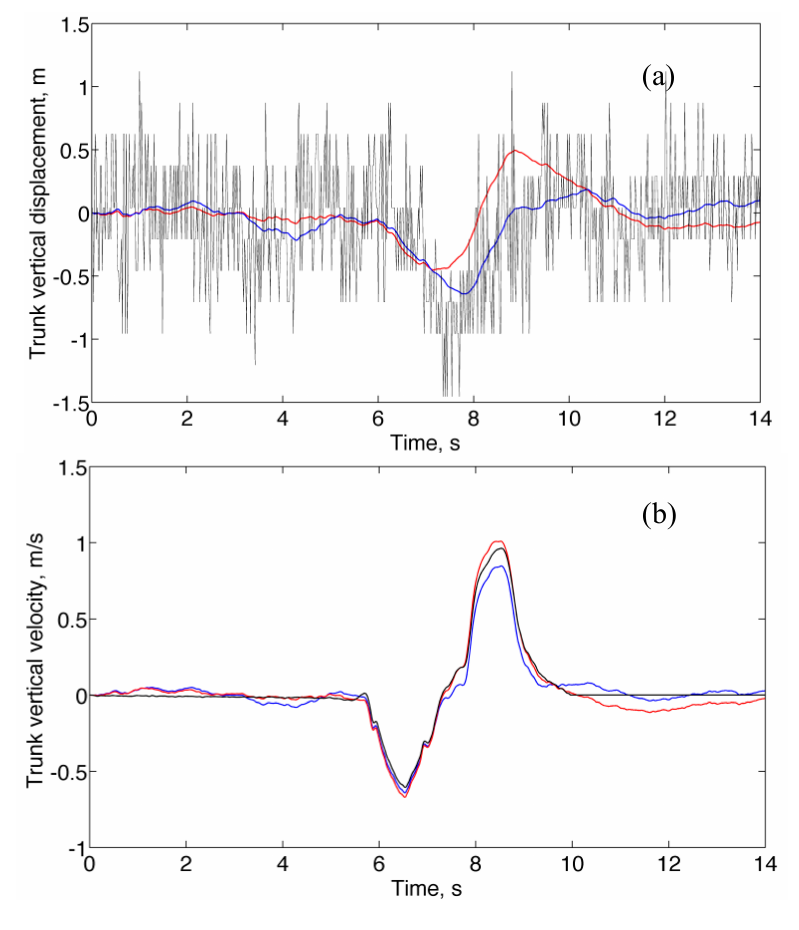
Figure 6. Squatting motion. ( a ) Trunk vertical displacement estimated by Method A (blue) and Method B (red) with superimposed the raw pressure altitude (black); ( b ) Trunk vertical velocity estimated by Method A (blue) and Method B (red), with superimposed the estimate by the reference method